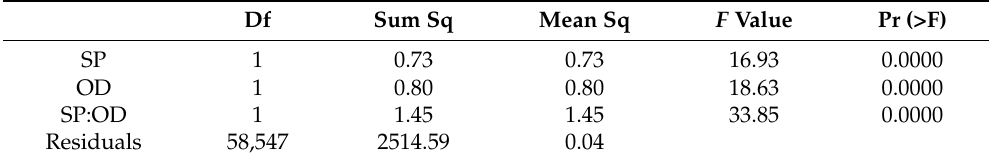
Table 1. Fixed-effects ANOVA using engagement as the criterion. SP (sponsored) & OD (out degree). Df Sum Sq Mean